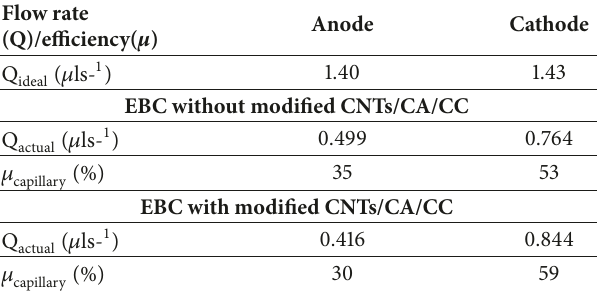
Table 1: The capillary driven fluid